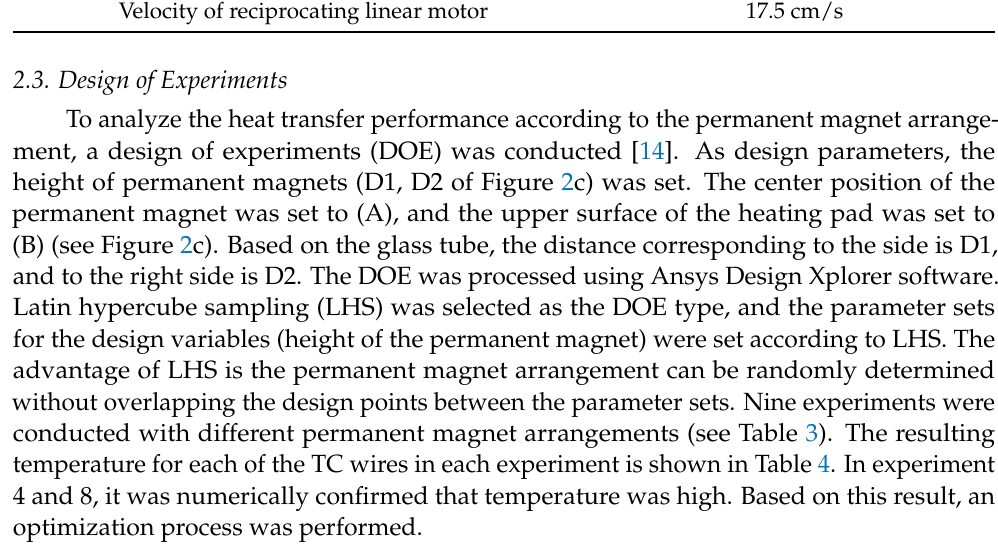
Table 3. Parameter sets based on DOE.